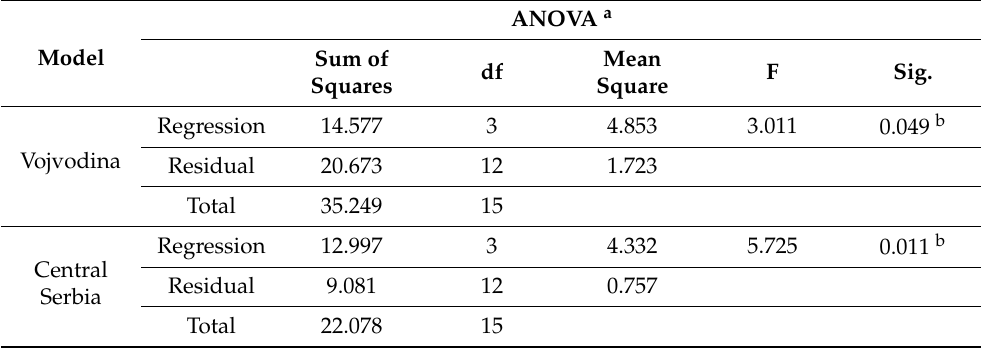
Table 4. Indicators of regression analysis for the correlation of climatic elements and maize yield in the Republic of Serbia for the period